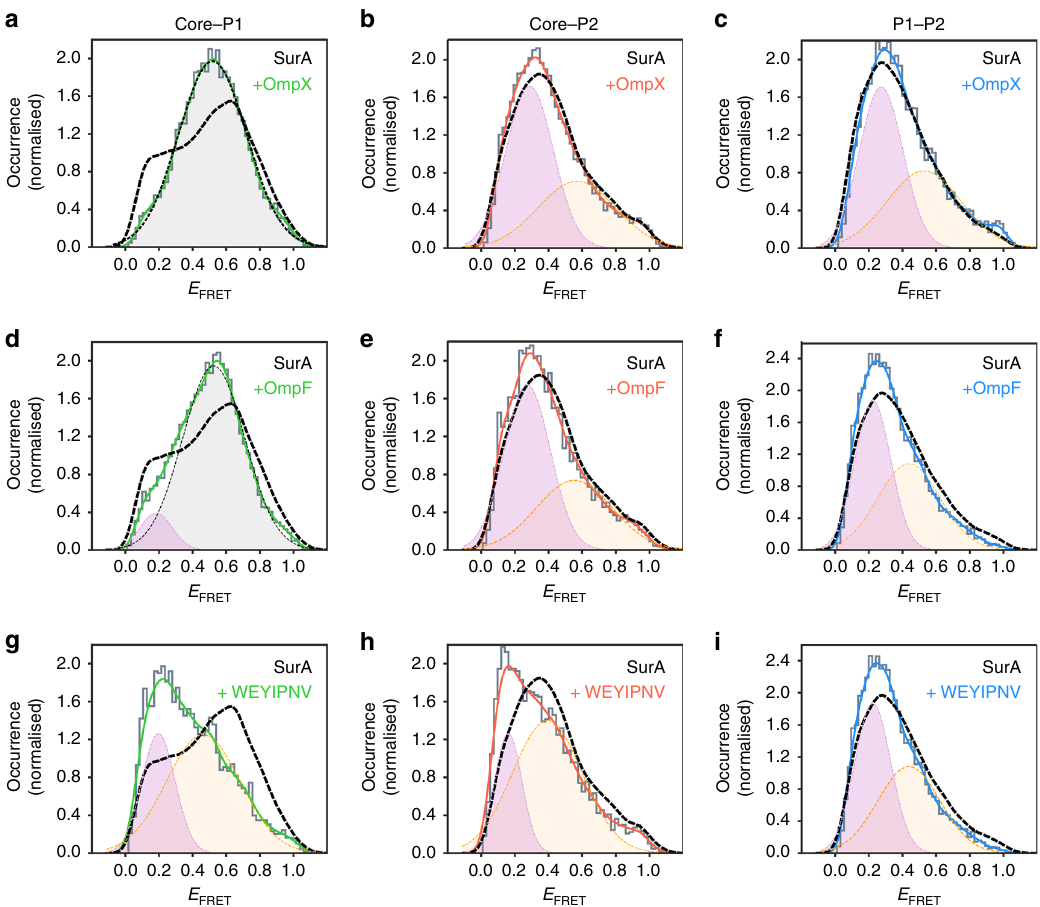
Fig. 7 Response of SurA inter-domain distances to substrate binding measured by smFRET. Experimentally measured E FRET distributions (grey) at equilibrium for the three pairwise combinations of fl uorescently-labelled SurA double mutants (core-P1, core-P2, and P1-P2) in the presence of a – c OmpX, d – f OmpF, or g – i WEYIPNV. Kernel density estimations (KDEs) of the probability density function of the measured E FRET values are shown as green, red and blue solid lines for a , d , g SurA core-P1, b , e , h core-P2 and c , f , i P1-P2 pairwise measurements in the presence of OmpX, OmpF or peptide WEYIPNV, respectively. Each were fi tted to a maximum of two Gaussians to appraise the ensemble heterogeneity (note that these do not necessarily represent true discrete states). Only a single Gaussian was used in ( a ) as this distribution is approximately unimodal. The corresponding apo-SurA distributions (black dashed lines, taken from Fig. 3d – f) are shown for reference to allow comparison between apo and holo SurA. Samples contained ~50 pM labelled SurA variant, 1.5 μ M OmpX/OmpF/WEYIPNV, in 50 mM Tris-HCl, pH 8.0, 25 °C, with a fi nal urea concentration of 0.24 M in the OMP-containing